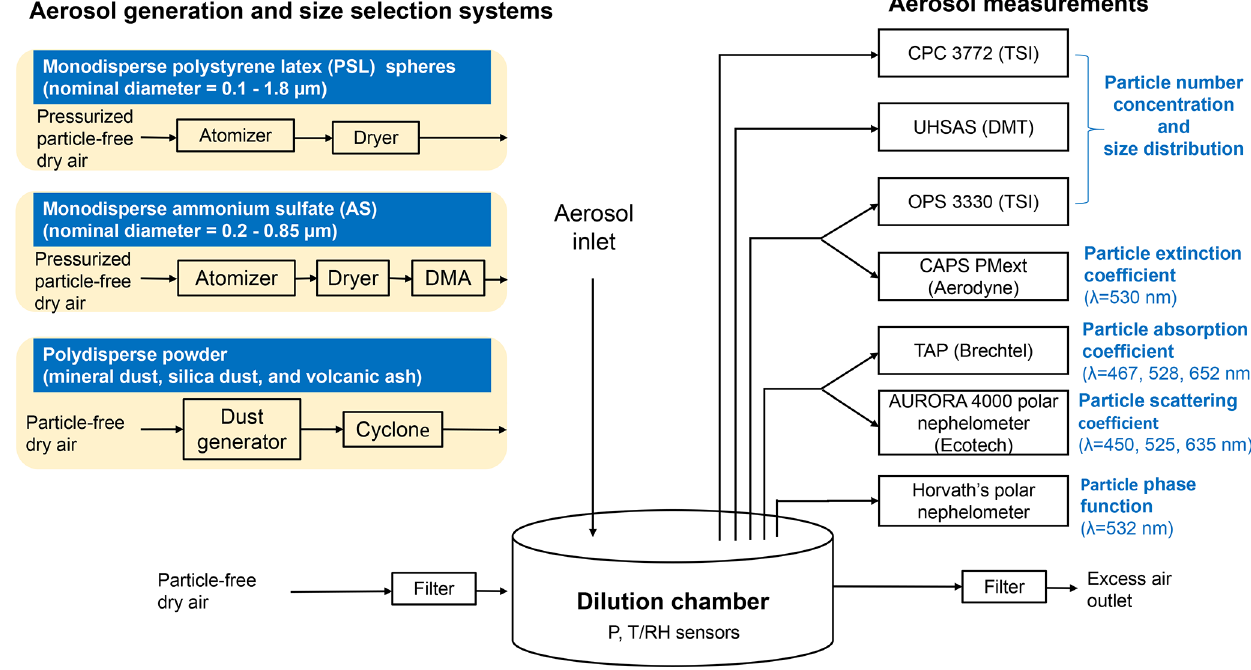
Figure 1. Scheme of the laboratory closure experiment set-up. Different aerosol types, such as monodisperse polystyrene latex (PSL) spheres, ammonium sulfate (AS), and polydisperse powder (mineral dust, silica dust, and volcanic ash), were generated using three different aerosol generation and size selection systems (in the upper left). The aerosol generation and size selection systems were connected via the aerosol inlet to a dilution chamber, where the aerosol flow is mixed with particle-free dry air. The dilution chamber was operated at a pressure slightly above ambient. Seven measurement instruments were connected to the dilution chamber to measure extinction, scattering, and absorption aerosol properties as well as particle number concentration and size